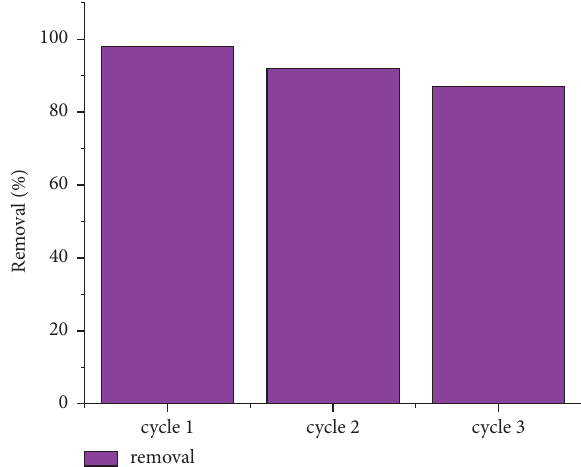
Figure 17: Recycling efciency of HAp NPs on fuoride